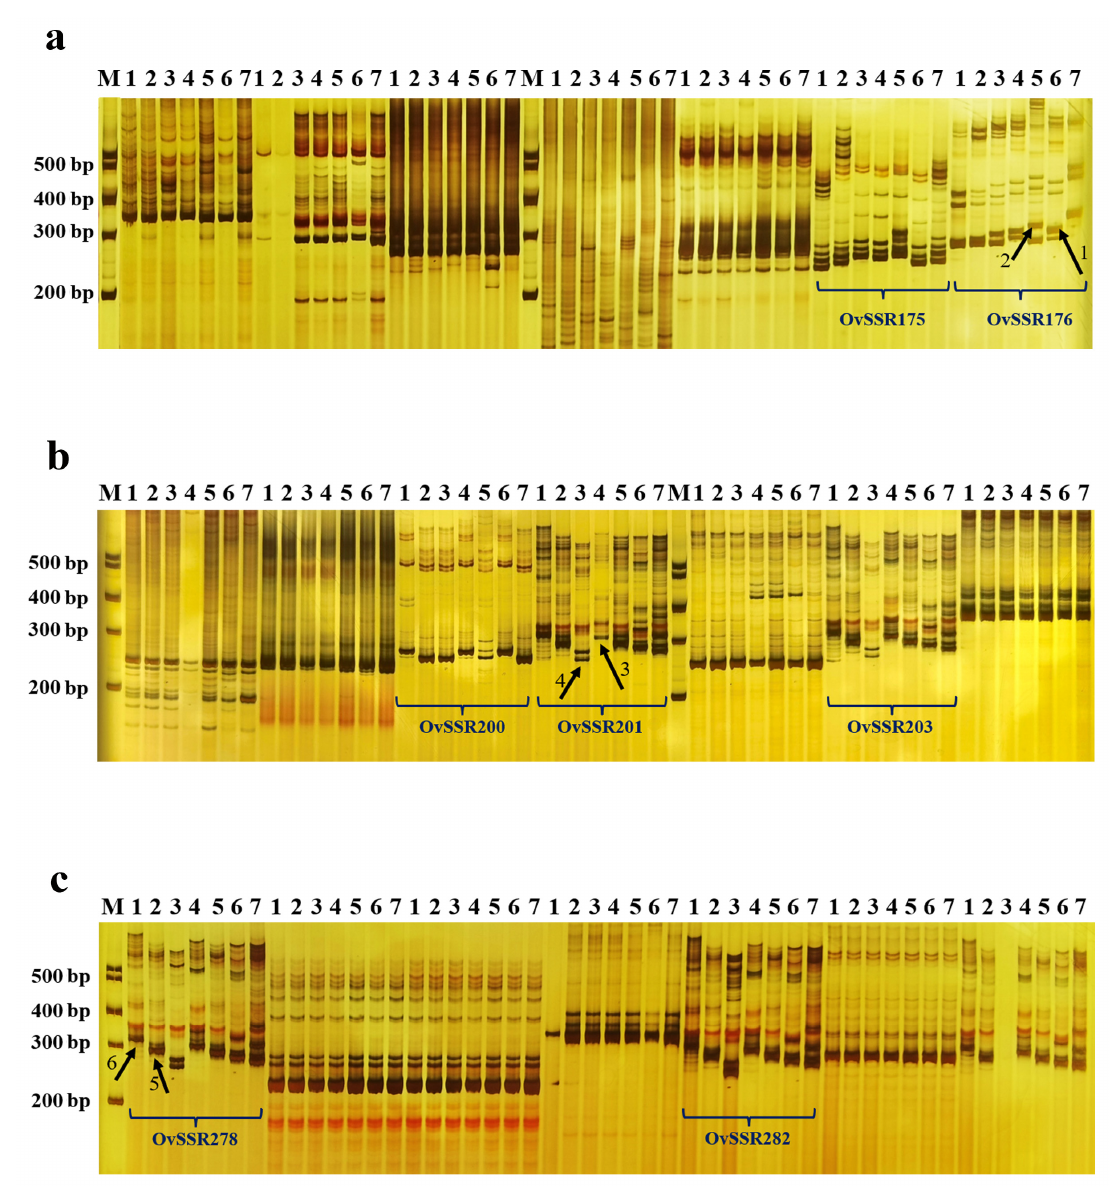
Figure 4. Genotyping of the seven parents of six hybrid combinations using codominant SSR markers. ( a – c ) Genotyping using OvSSR175 and OvSSR176 markers ( a ); OvSSR200, OvSSR201, and OvSSR203 markers ( b ); and OvSSR278 and OvSSR282 markers ( c ). M, DNA Marker; 1, Ovh; 2, Ovv; 3, Ovs; 4, Ovhs; 5, Ovc; 6, Omh; 7, Ov. Arrows 1–6 show the characteristic bands amplified in the parents of the six hybrid combinations.